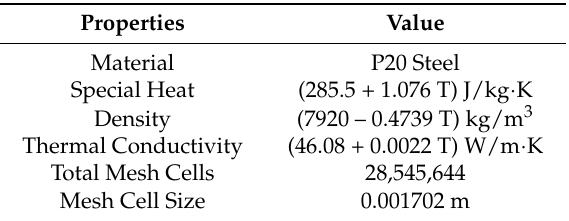
Table 2. Boundary conditions and mesh properties.